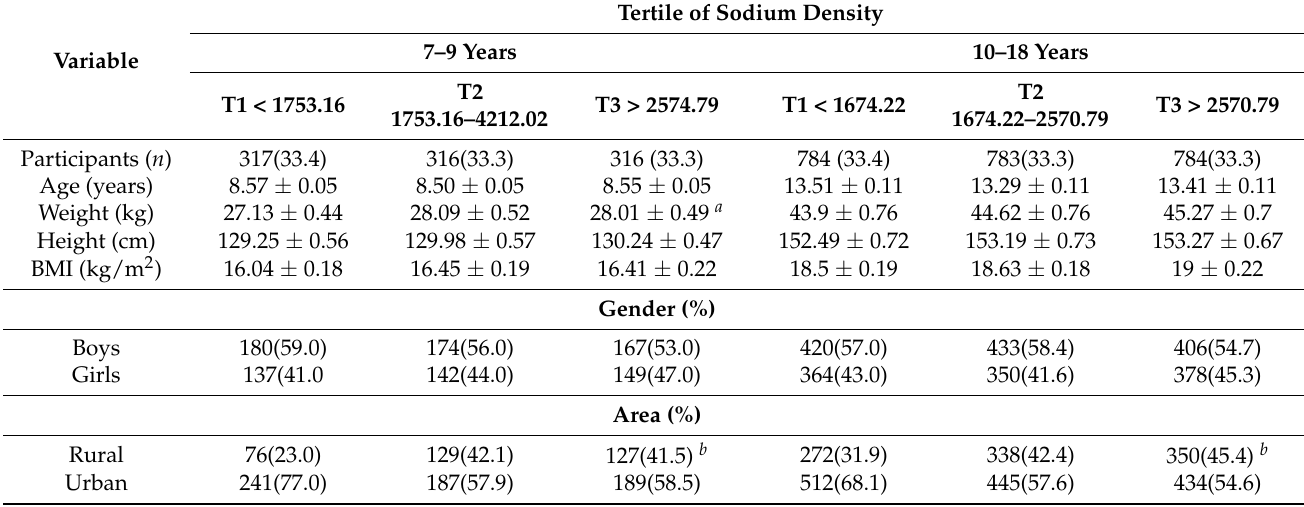
Table 3. Anthropometric measurements according to tertiles of sodium density among Chinese children and adolescents aged 7–18